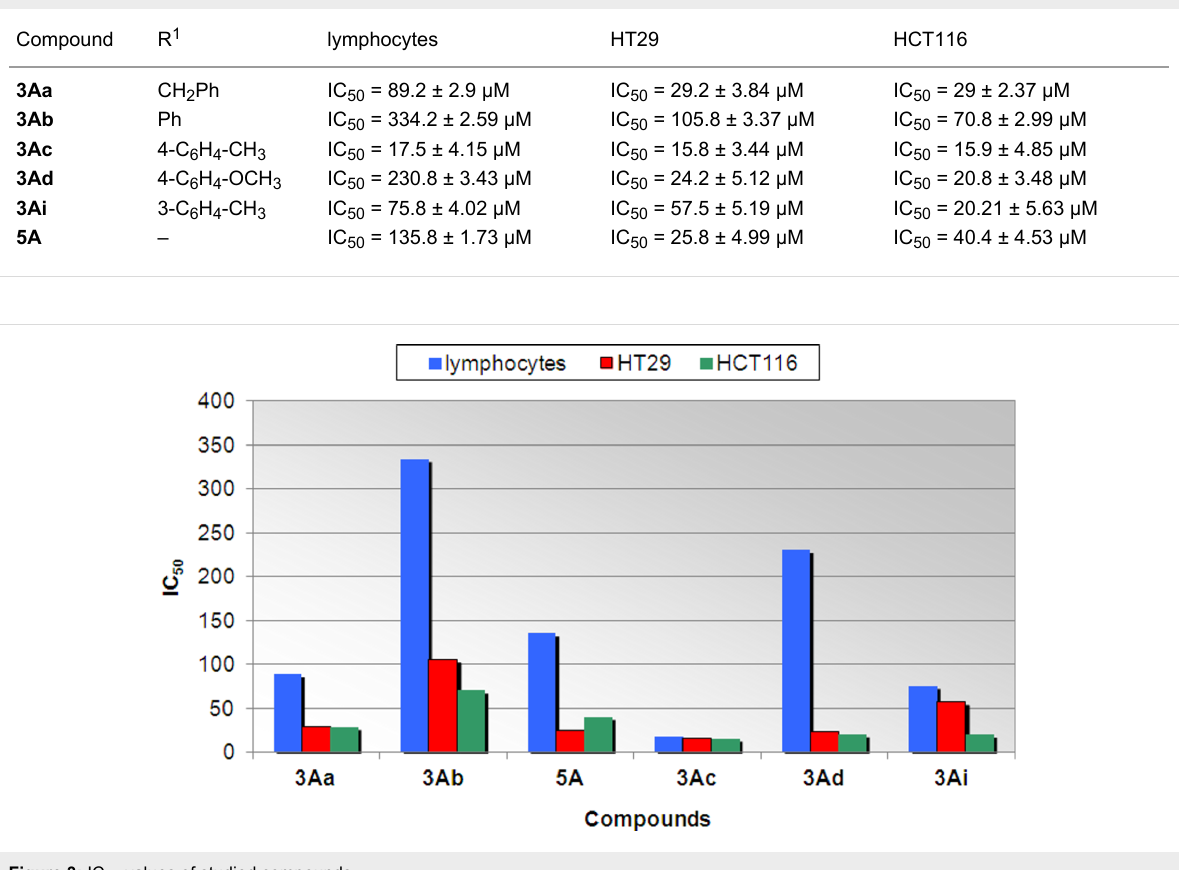
Figure 3: IC 50 values of studied